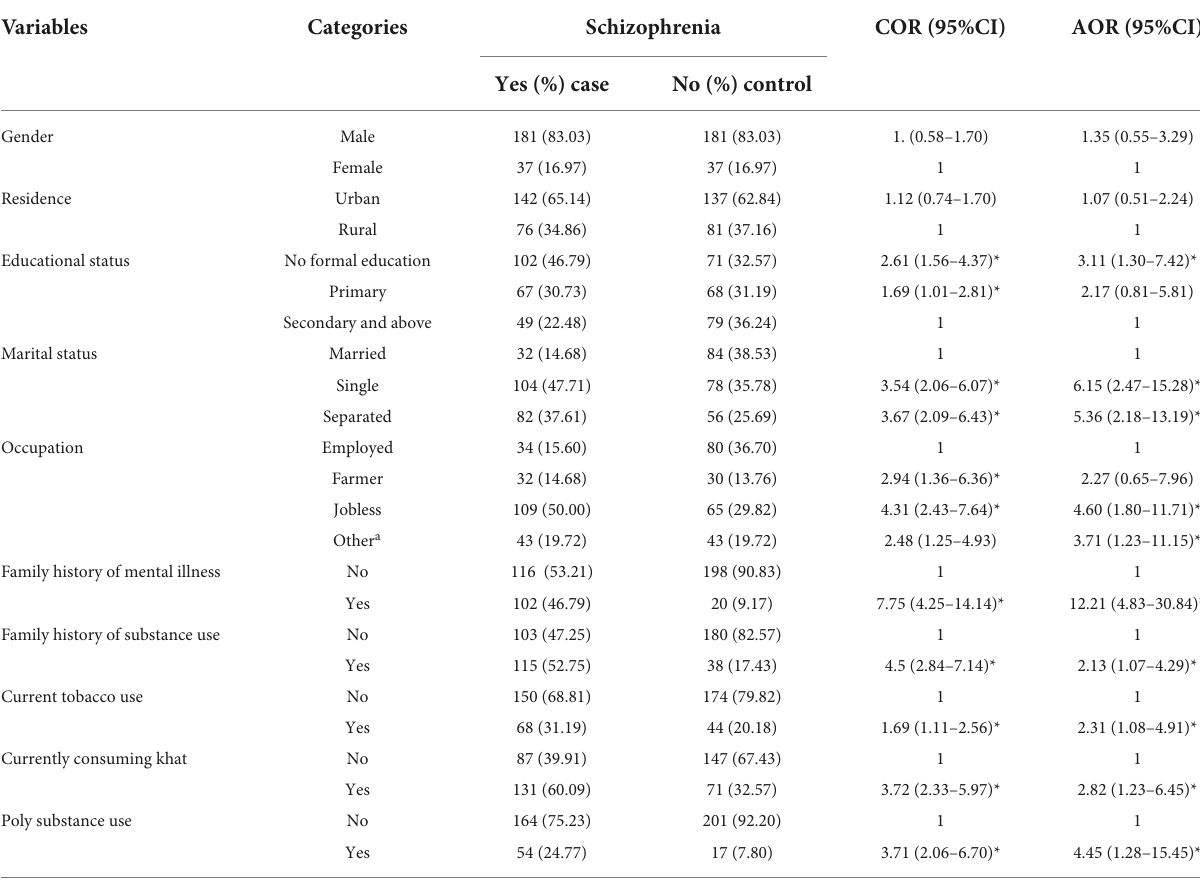
TABLE 3 Bivariable and Multivariable conditional logistic regression model showing risk factors of schizophrenia at selected public hospitals in eastern Ethiopia from December 1, 2021 to January 30,